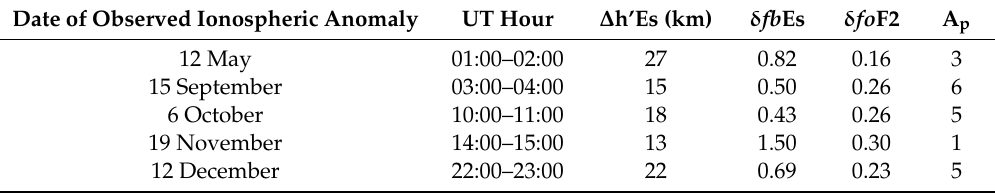
Table 4. Ionospheric anomalies during 2016 not related to EQs. Daily A p indices are given as well. Date of Observed Ionospheric